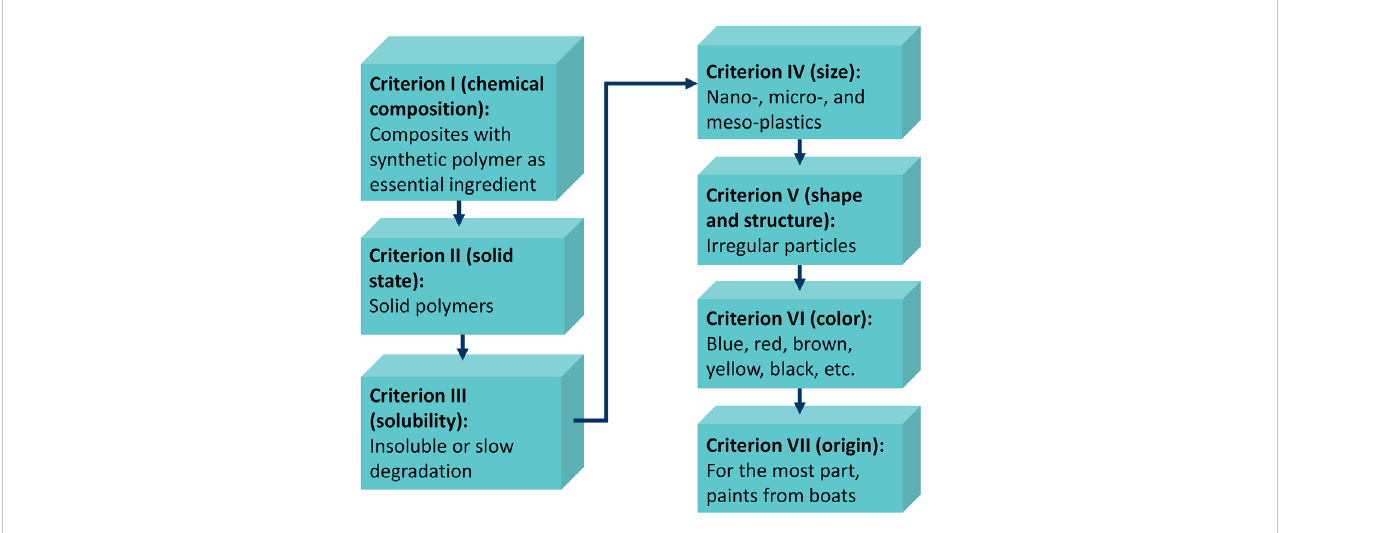
FIGURE 1 Paint microplastics de fi nition following the common framework by Hartmann et